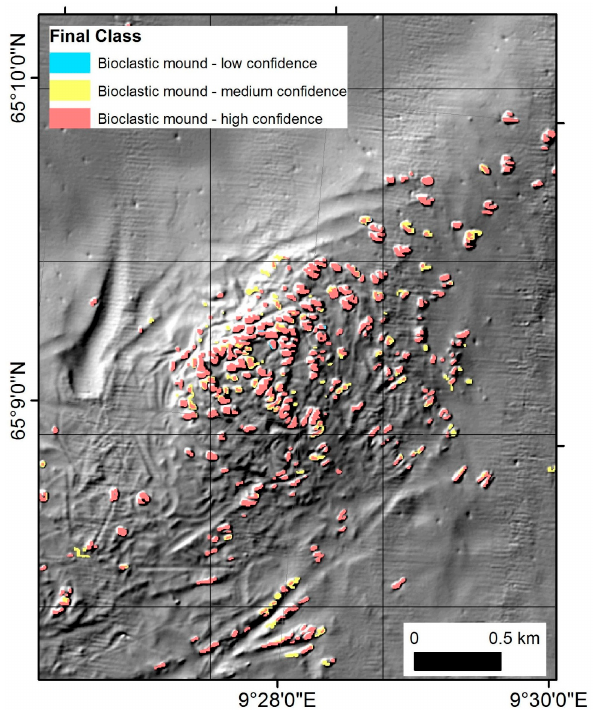
Figure 5 . Left—Example detail of mapping results showing predicted occurrence of carbonate mounds and associated total confidence overlaid on a hillshade image of the bathymetry. Also visible is the 1 km by 1 km raster used to aggregate data on carbonate mounds.